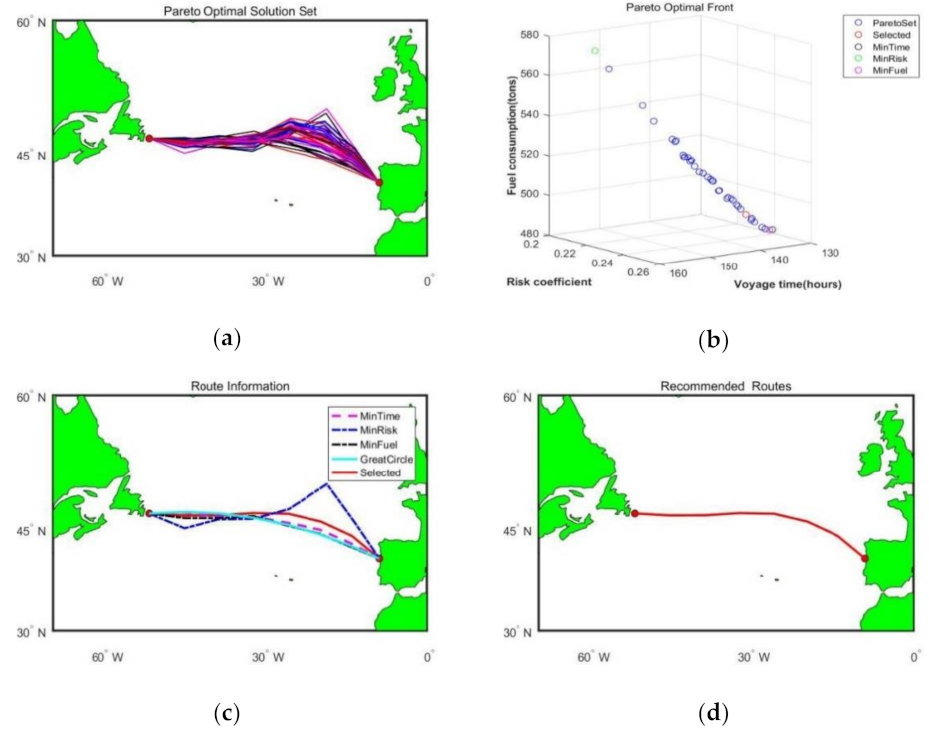
Figure 7. Ship route optimization results under good sea conditions: ( a ) the Pareto optimal solution set of the multicriteria route; ( b ) the Pareto optimal frontier solution; ( c ) great circle route and four optimized routes; and ( d ) recommended